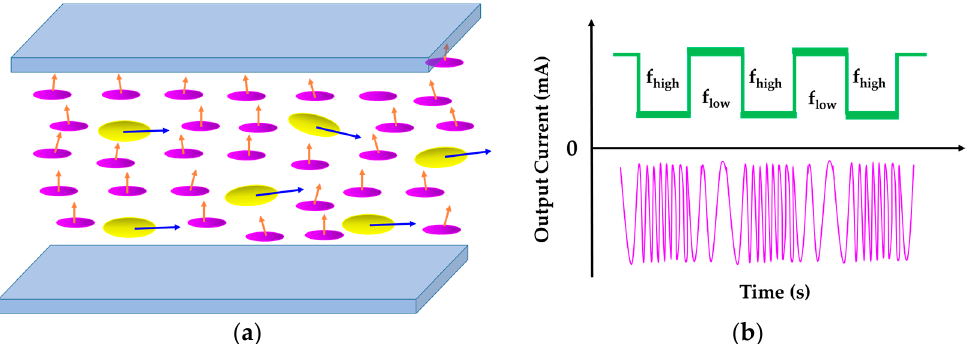
Figure 15. ( a ) A dual frequency nematic liquid crystals (DFNLC) mixture at the planar orientation: This mixture is composed of two categories of nematic liquid crystals (NLC), one having transverse (orange arrow) and other having longitudinal (blue arrow) dipole moments; ( b ) the bistable switching of a DFNLC/CNT composite with two applied frequencies for the ON state and the OFF state.